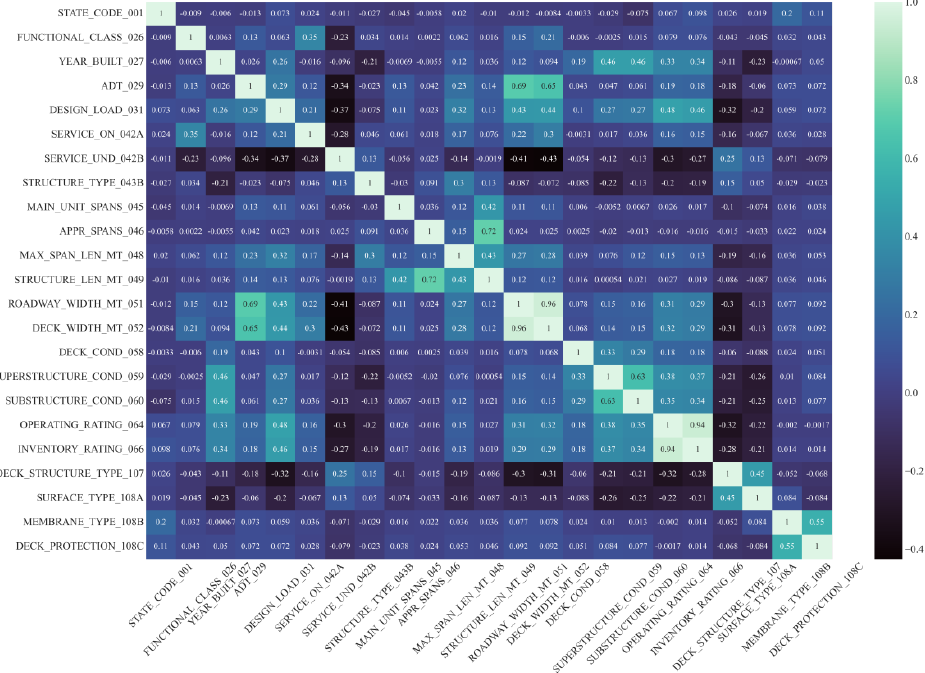
Figure 2. Pearson coefficient correlation matrix.